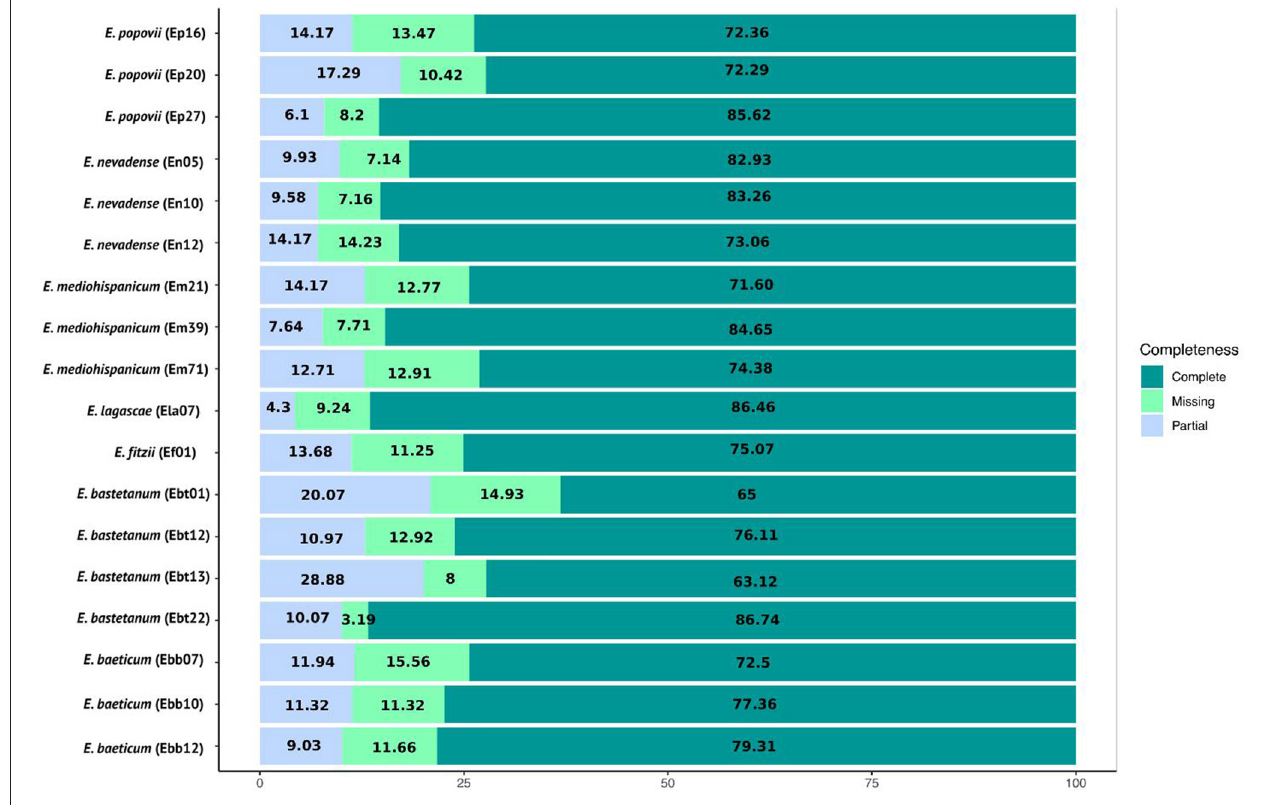
FIGURE 1 | BUSCO assessment results for the 18 assembled